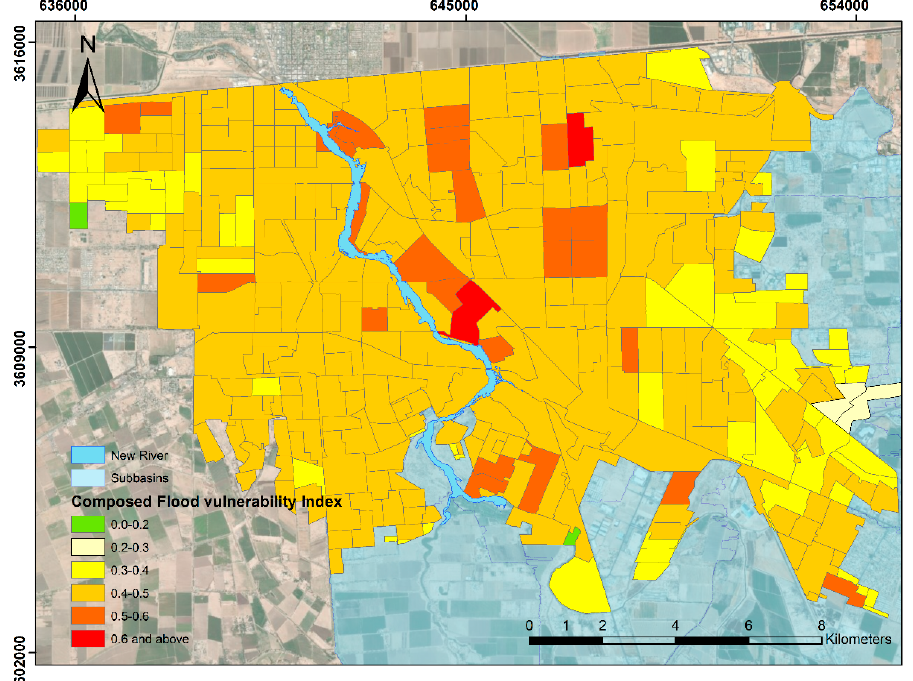
Figure 9. Composed flood vulnerability index for an AGEB scale.